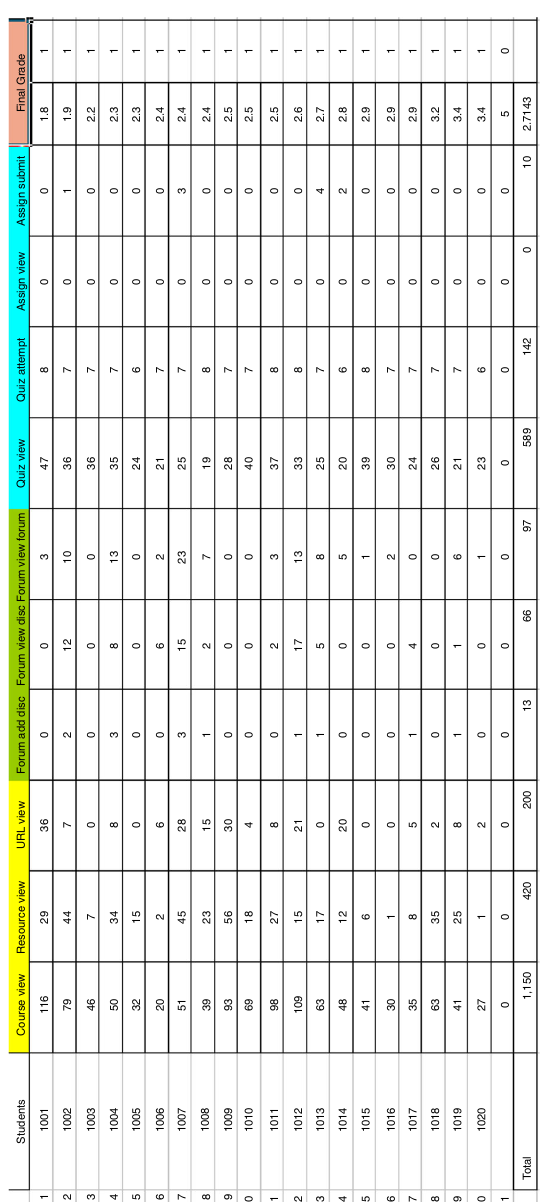
Figure 2. Preprocessed raw data (activity